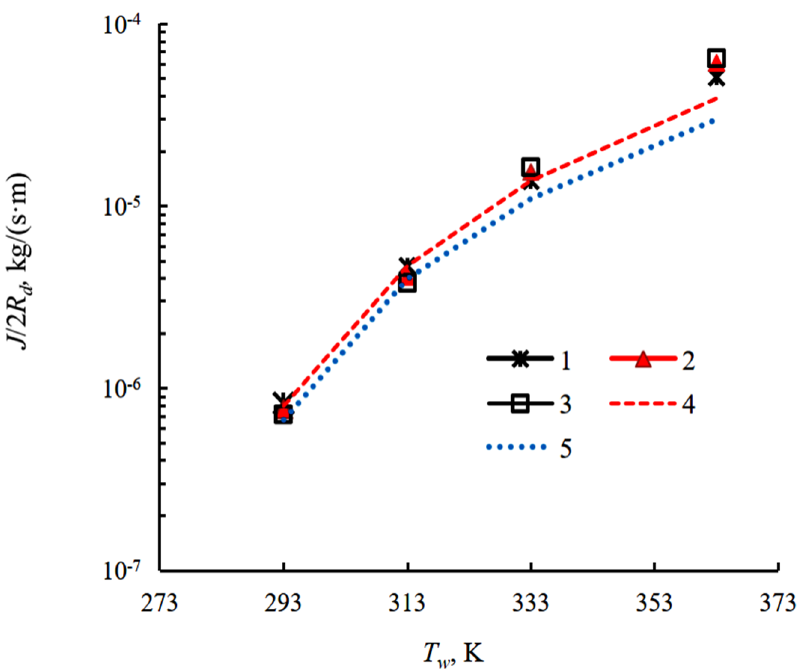
Figure 13. Drop evaporation rate depending on the wall temperature T w . Experimental results: 1—water, 2—water with surfactant (1000 ppm), 3—water with surfactant (10,000 ppm); and by calculation from Equation (10) for the droplet contact angle: 4—of 60°, and 5— of 27°.